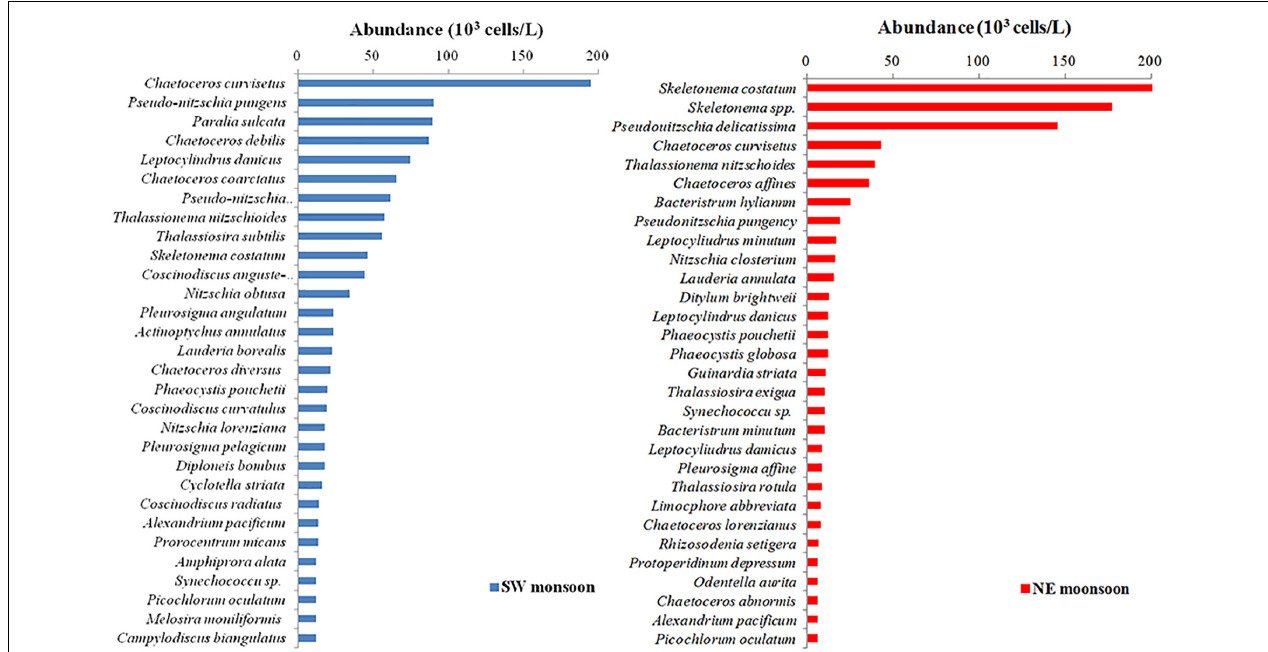
FIGURE 2 | Top 30 ranking of phytoplankton abundance during southwest (SW) and northeast (NE) monsoon in Qinzhou Bay. TABLE 2 | Two-way ANOVA and F -test for selected specific biogeochemical parameters. Parameters Intercept Season Sector Season*Sector